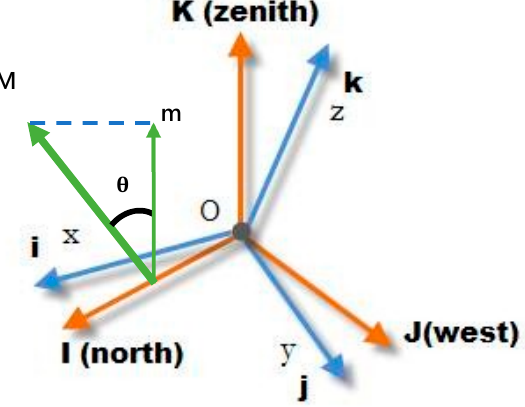
Figure 6. Vertical and horizontal components obtained from gravity.